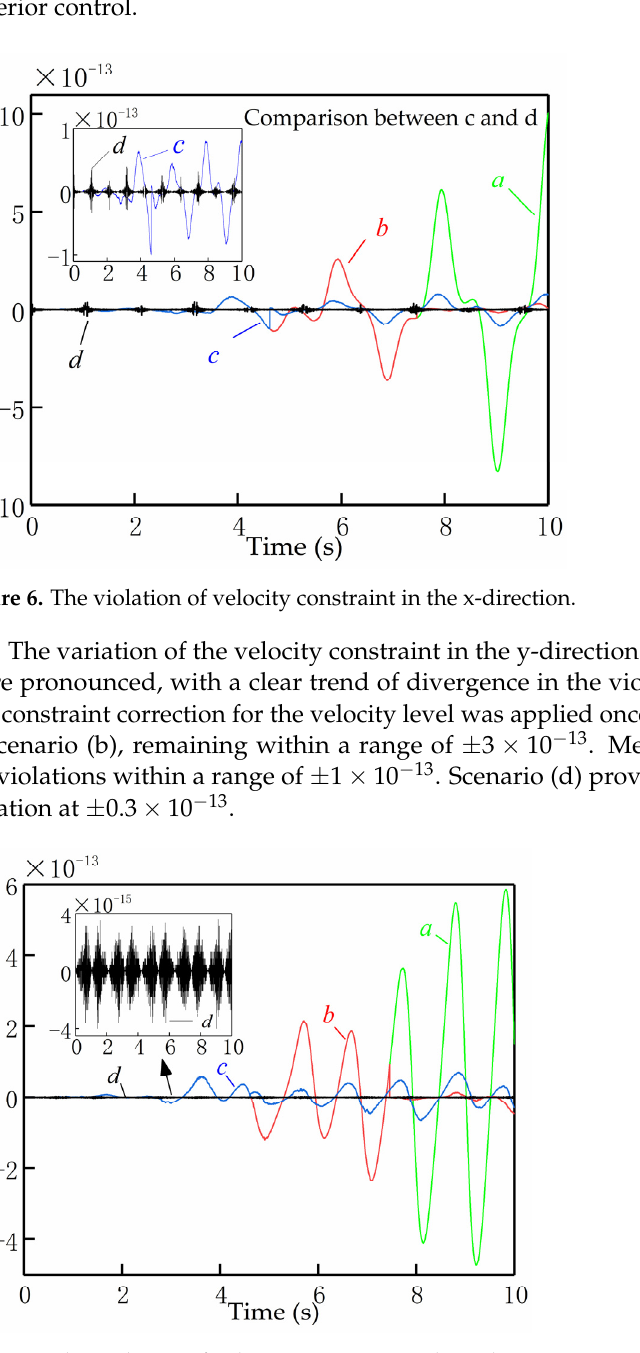
Figure 7. The violation of velocity constraint in the y-direction.